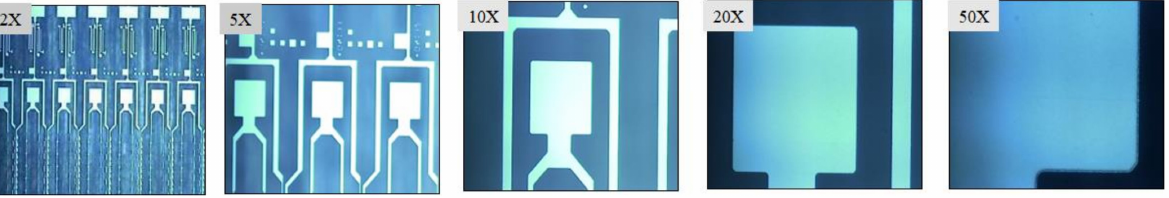
Figure 12. Various magnification lens with 2 × , 5 × , 10 × , 20 × , and 50 × are illustrated by area-CCD. Table 2 addresses several lenses, a set of 350,000-pixel area-CCD, pixel number, res- olution, and field of view (FOV) with various magnifications. The 50 × magnification is a critical saturation as the smallest FOV 128 × 96 µ m on the presented task. Thus, the environmental condition requests a planarity stage to prevent out of focus. The task utilizes a set of objective turrets installed five sets of the lens in the experiment, which descending order are 2 × , 5 × , 10 × , 20 × , and 50 × ,